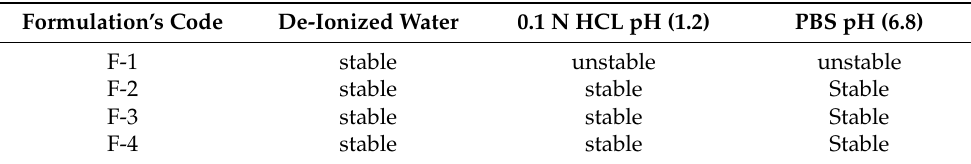
Table 5. Robustness to dilution studies of cefixime-loaded SEDDS formulations in different